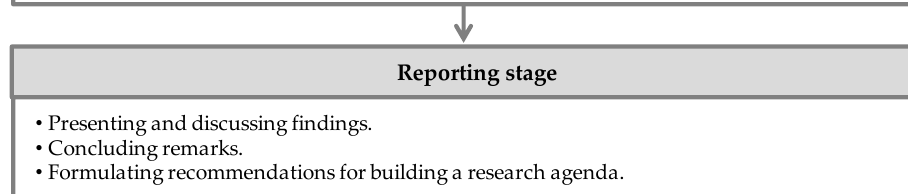
Figure 1. The literature review process’ schematic representation adapted from Ref. [26].